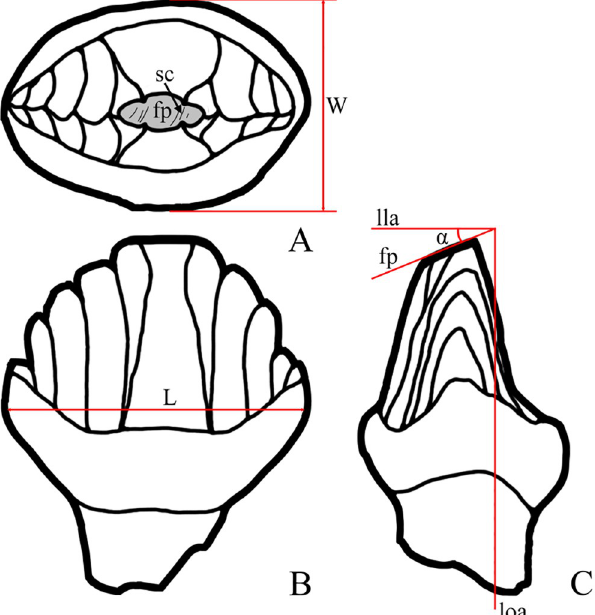
Fig 1. Diagrams illustrating measurements and wear elements of isolated stegosaur teeth. Stegosaur tooth in occlusal view (A), labial or lingual view (B), and mesial or distal view (C). Abbreviations: W, crown width; L, crown length; fp, facet plane; sc, wear scratches; lla, labiolingual axis of the crown; loa, longitudinal axis of the crown; α , facet